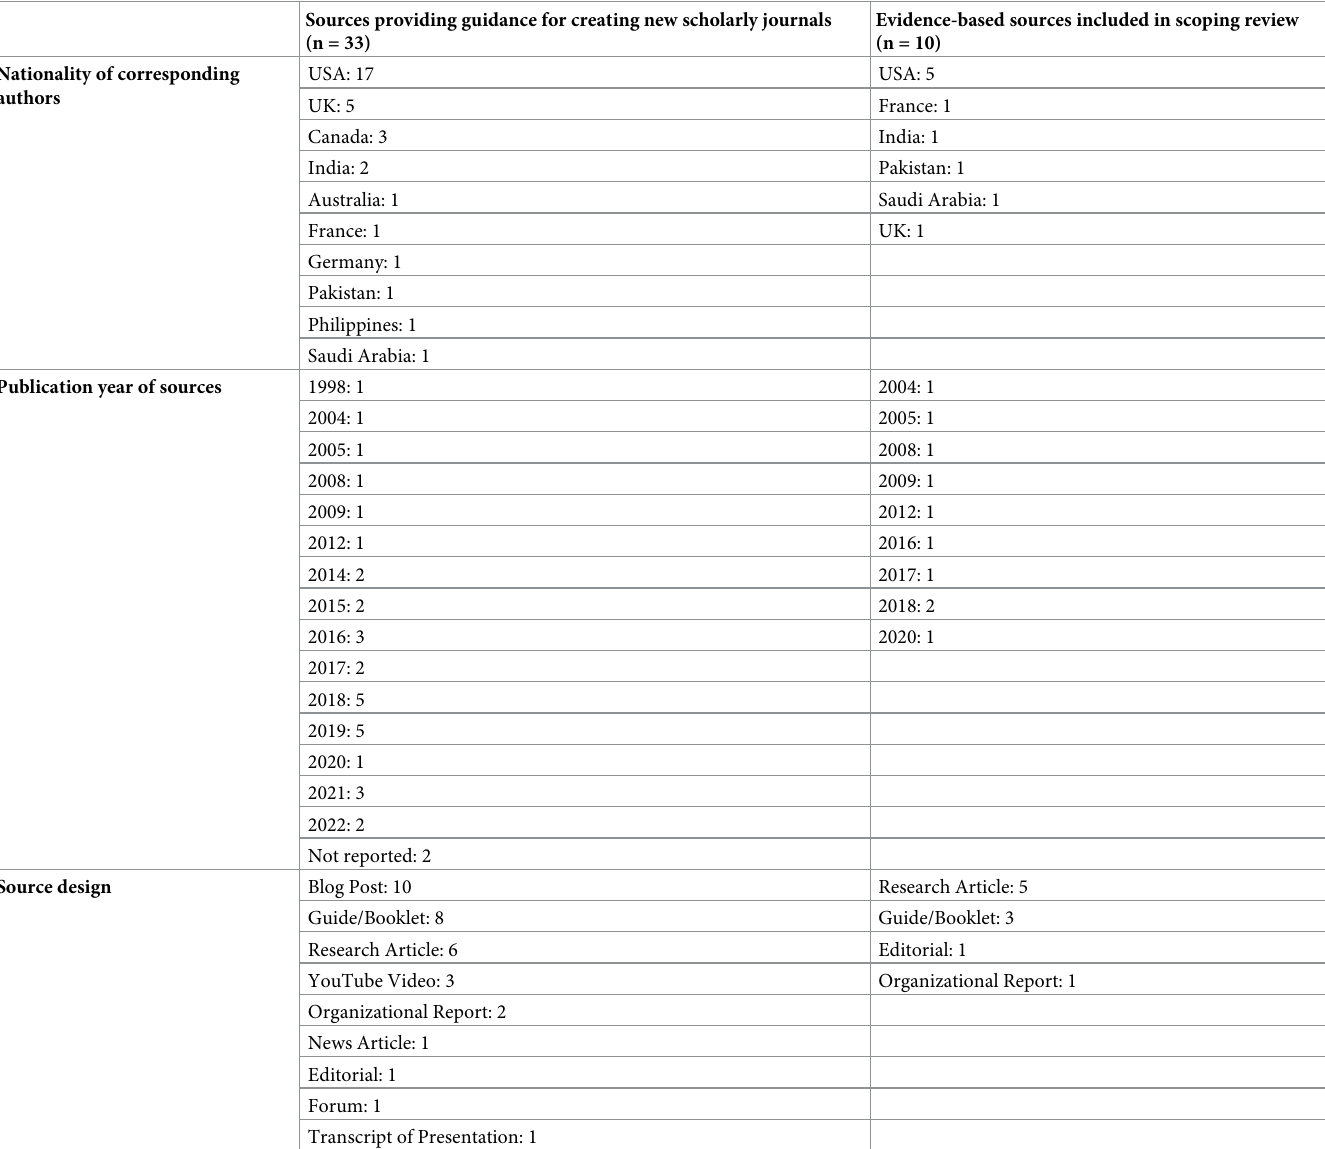
Table 4. Characteristics of all included sources mentioning recommendations for new scholarly journal creation and characteristics of included evidence-based sources. Sources providing guidance for creating new scholarly journals (n =